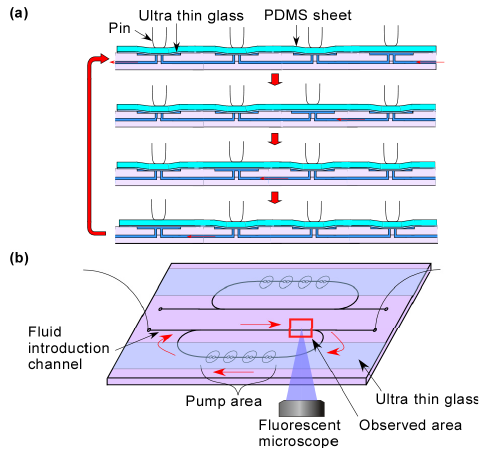
Figure 1. Design and principle of a peristaltic pump on a 100% glass-based microchip. ( a ) Cross-sectional view showing the working principle of the pump. By moving an open chamber to the left, fluid is also moving to left. The ultra thin glass is covered with a protective PDMS sheet. ( b ) The design and observation method of a prototype chip for pump